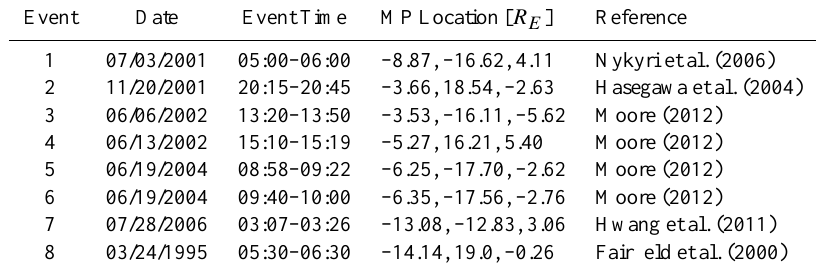
Table 1. Event dates, times, and GSM location for Cluster spacecraft 1 (Events 1–7) and Geotail (Event